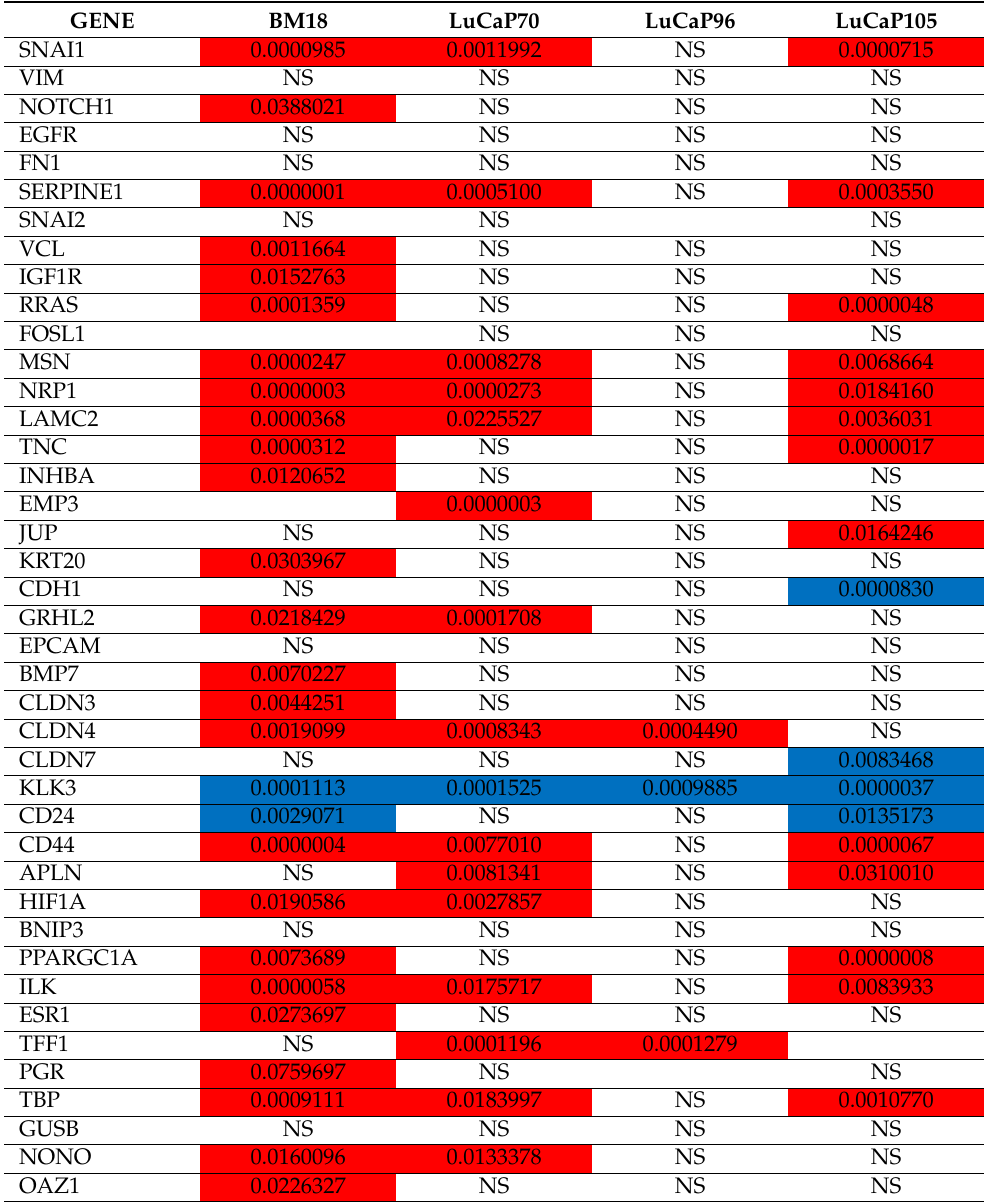
Table 3. Summary of gene expression differences between CTC and primary tumour samples ( p values shown) across PDX